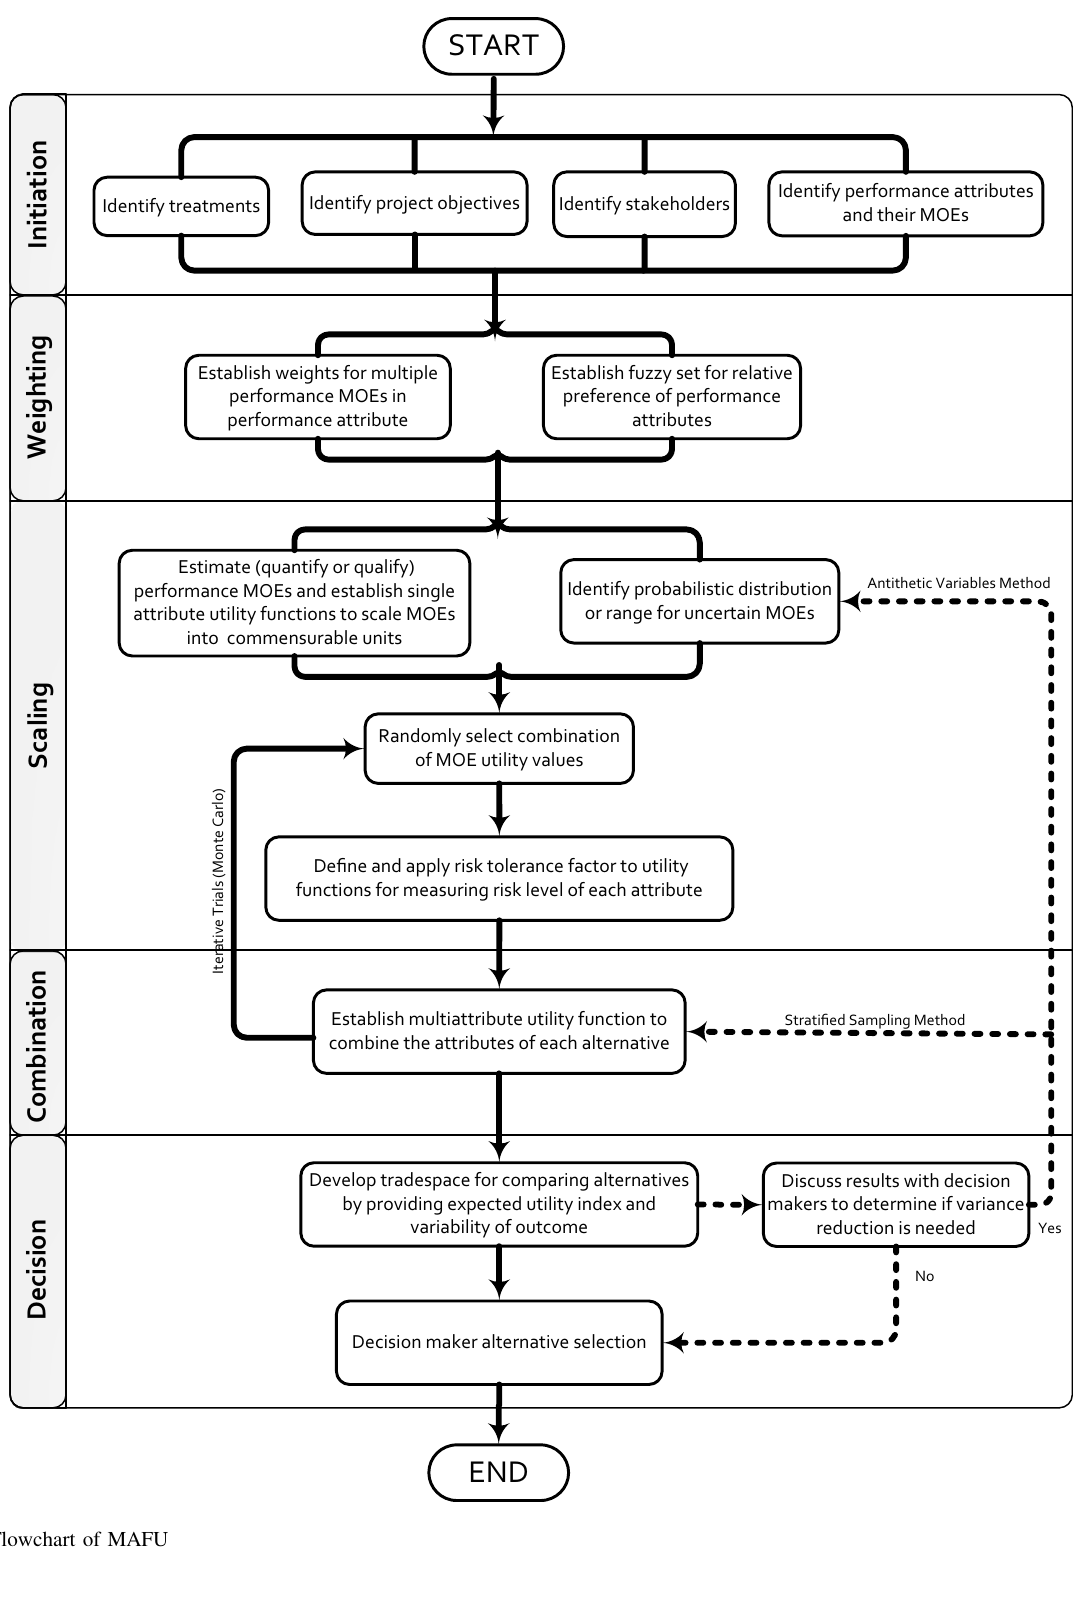
Fig. 2 Flowchart of